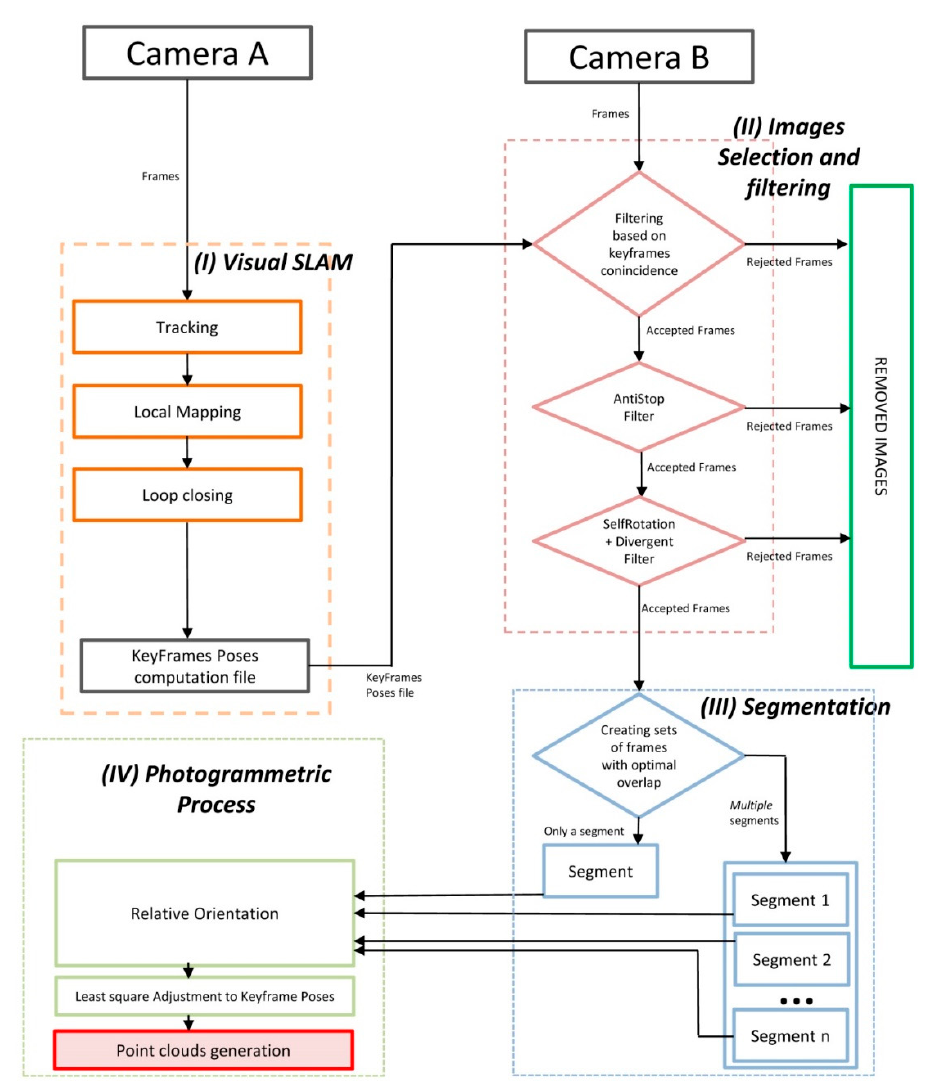
Figure 3. General workflow of the algorithm implemented in C++ for the computations.